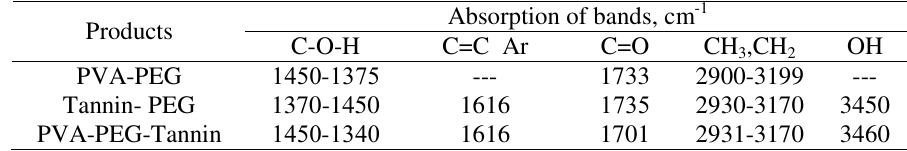
Table 1. The important FT.IR bands of